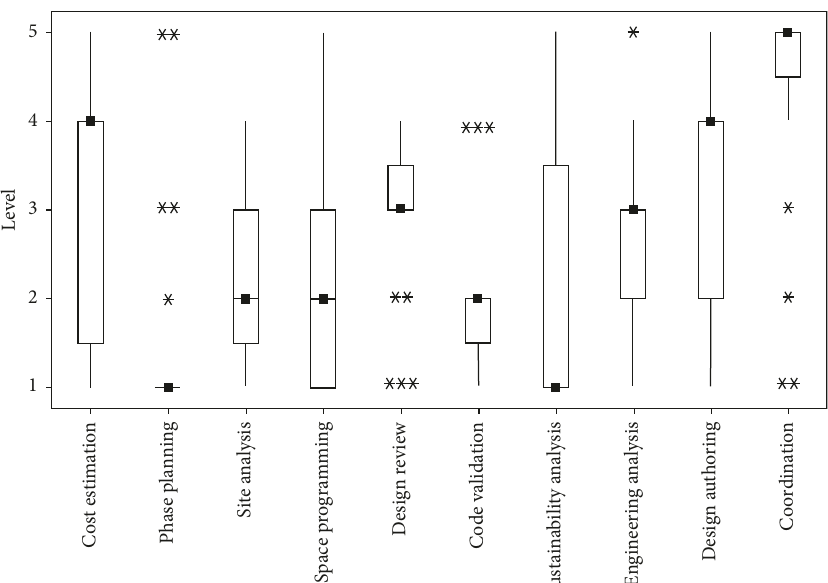
Figure 4: BIM use application